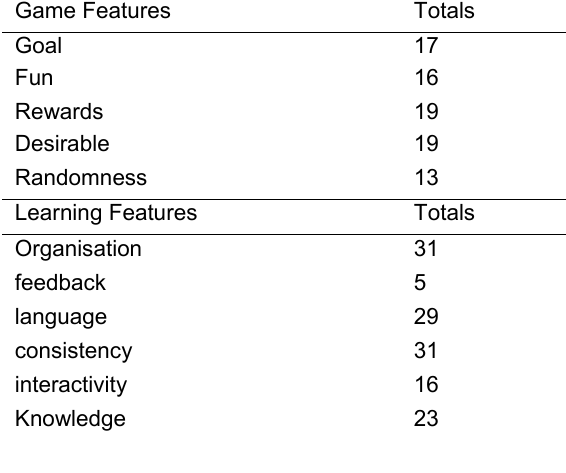
Table 1. Totals for each characteristic Game